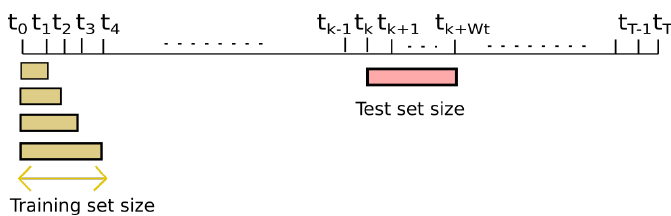
Figure 6. Case 1: Training set size increases in forward direction. Test set size fixed.